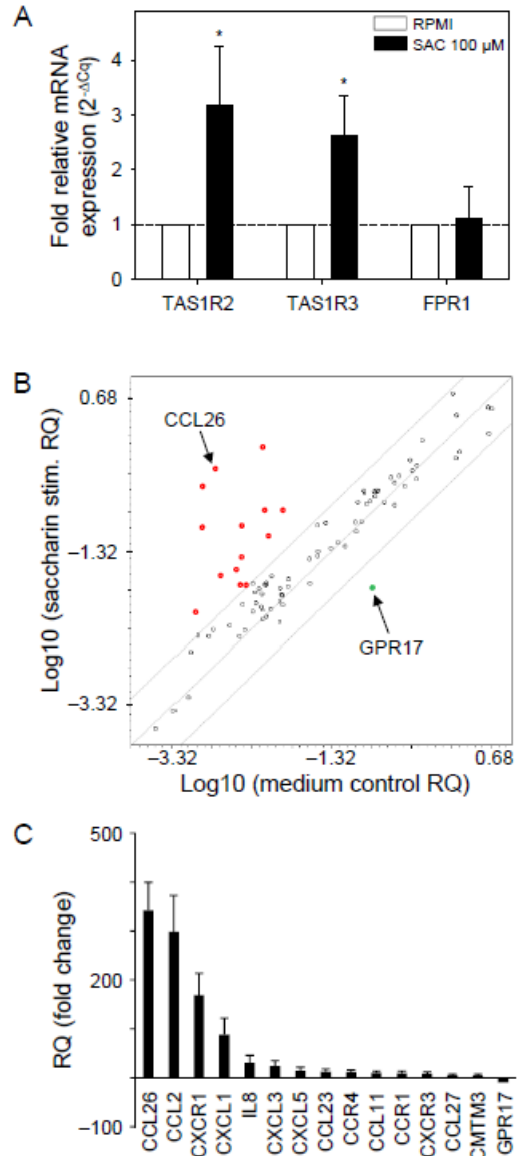
Figure 2. Transcriptional regulation by saccharin of the sweet taste receptor, cytokines, and their cognate receptors in isolated neutrophils in vitro. Isolated neutrophils from buffy coat samples were incubated with saccharin (100 µ M) in comparison to RPMI medium for 24 h. ( A ) Transcript levels of TAS1R2, TAS1R3, and FPR1 were obtained from RT-qPCR and are given as 2 −∆ Cq , normalized to each respective standard condition (RPMI) (dashed line). Data are shown as mean ± SEM ( n = 7 buffy coat samples). Differences in expression levels were tested versus each RPMI condition by paired t -test (* p < 0.05, two-tailed). ( B ) Scatter plot compares normalized mRNA expression levels between saccharin- and medium-treated samples of 84 genes coding for neutrophil-related cytokines and their receptors (Table S1). Every gene-specific normalized expression level in one group is plotted on one axis against the corresponding value in the other group on the other axis on a log base 10 scale to visualize gene expression changes. The mean fold change in relative quantification (RQ) normalized to medium control ( n = 3) is shown. Fold changes in gene expression between lines are not significant (black circles, p > 0.05). Up-regulated mRNA (red circles) was observed for 14 cytokines and receptors, the highest being CCL26. Down-regulation (green circle) was detected for GPR17. ( C ) Ranked expression of significantly regulated genes in ( B ) is plotted as mean fold change. Data are shown as mean ±